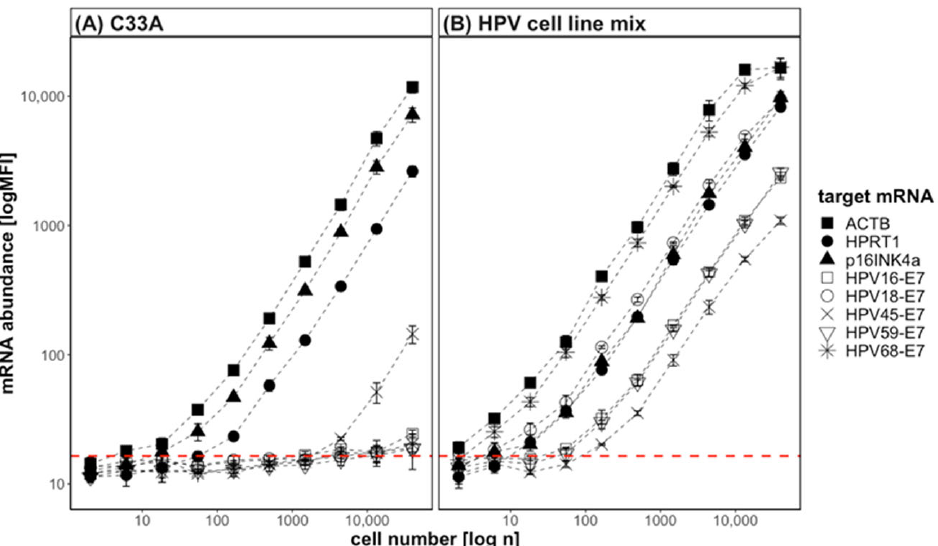
Figure 2. Limiting dilution titration of cell lines tested by QG-POC assay. The cell lysates of 40,000 cells per cell line were serially diluted 1:3 and subjected to a QG-POC assay. ( A ) Cell line C33A (HPV-negative). ( B ) HPV cell line mix containing 2 × 10 6 cells/mL of each HPV-positive cell line (CaSki, HeLa, Erin59, Me180, CERV-215). MFI (+/ − SD, n = 2) is shown. The dashed red line indicates the mean LOD of all the